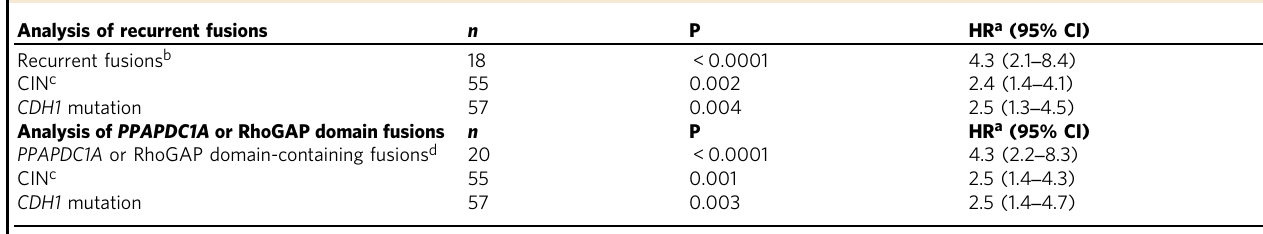
a HR: hazard ratio b Recurrent fusions: presence of TACC2-PPAPDC1A, CLDN18-ARHGAP26, CTNND1-ARHGAP26 , or ANXA2-MYO9A c CIN: chromosomal instability d PPAPDC1A or RhoGAP domain fusions: presence of TACC2-PPAPDC1A , ARIH1-PPAPDC1A, CLDN18-ARHGAP26 , CTNND1-ARHGAP26 , ANXA2-MYO9A, WDR7-ARHGAP26 , or